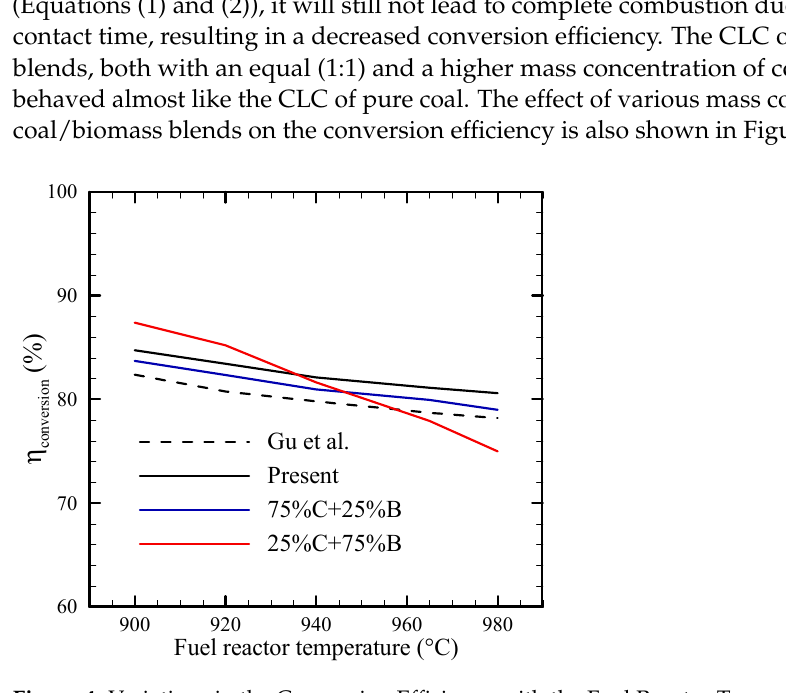
Figure 4. Variations in the Conversion Efficiency with the Fuel Reactor Temperature.